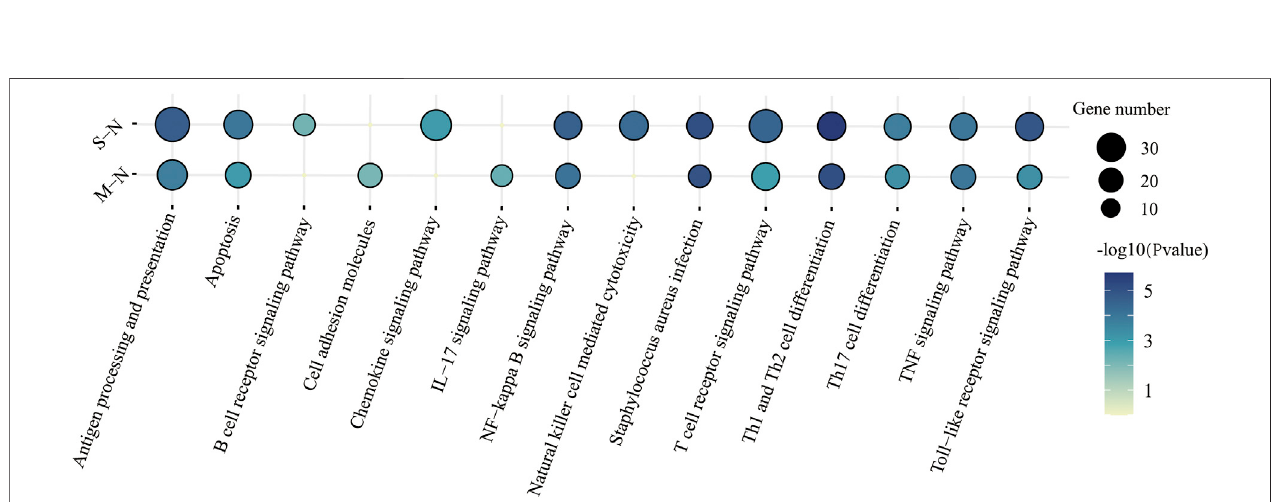
FIGURE 3 | KEGG functional characteristics for the predicted target genes of four lncRNAs in immune response between mild and severe COVID-19.